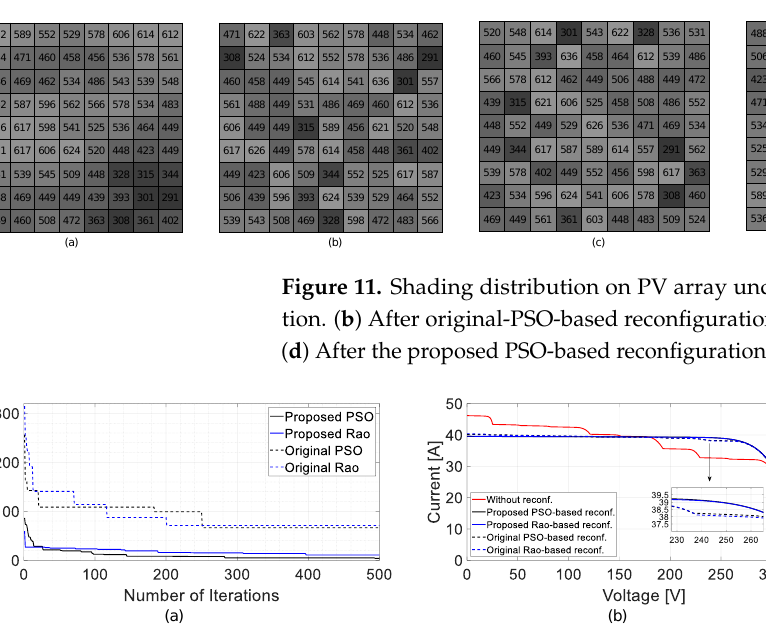
Figure 12. Comparison of characteristics of PV array under the center of the cloud. ( a ) Objective function over iterations. ( b ) I-V curves. ( c ) P-V curves.